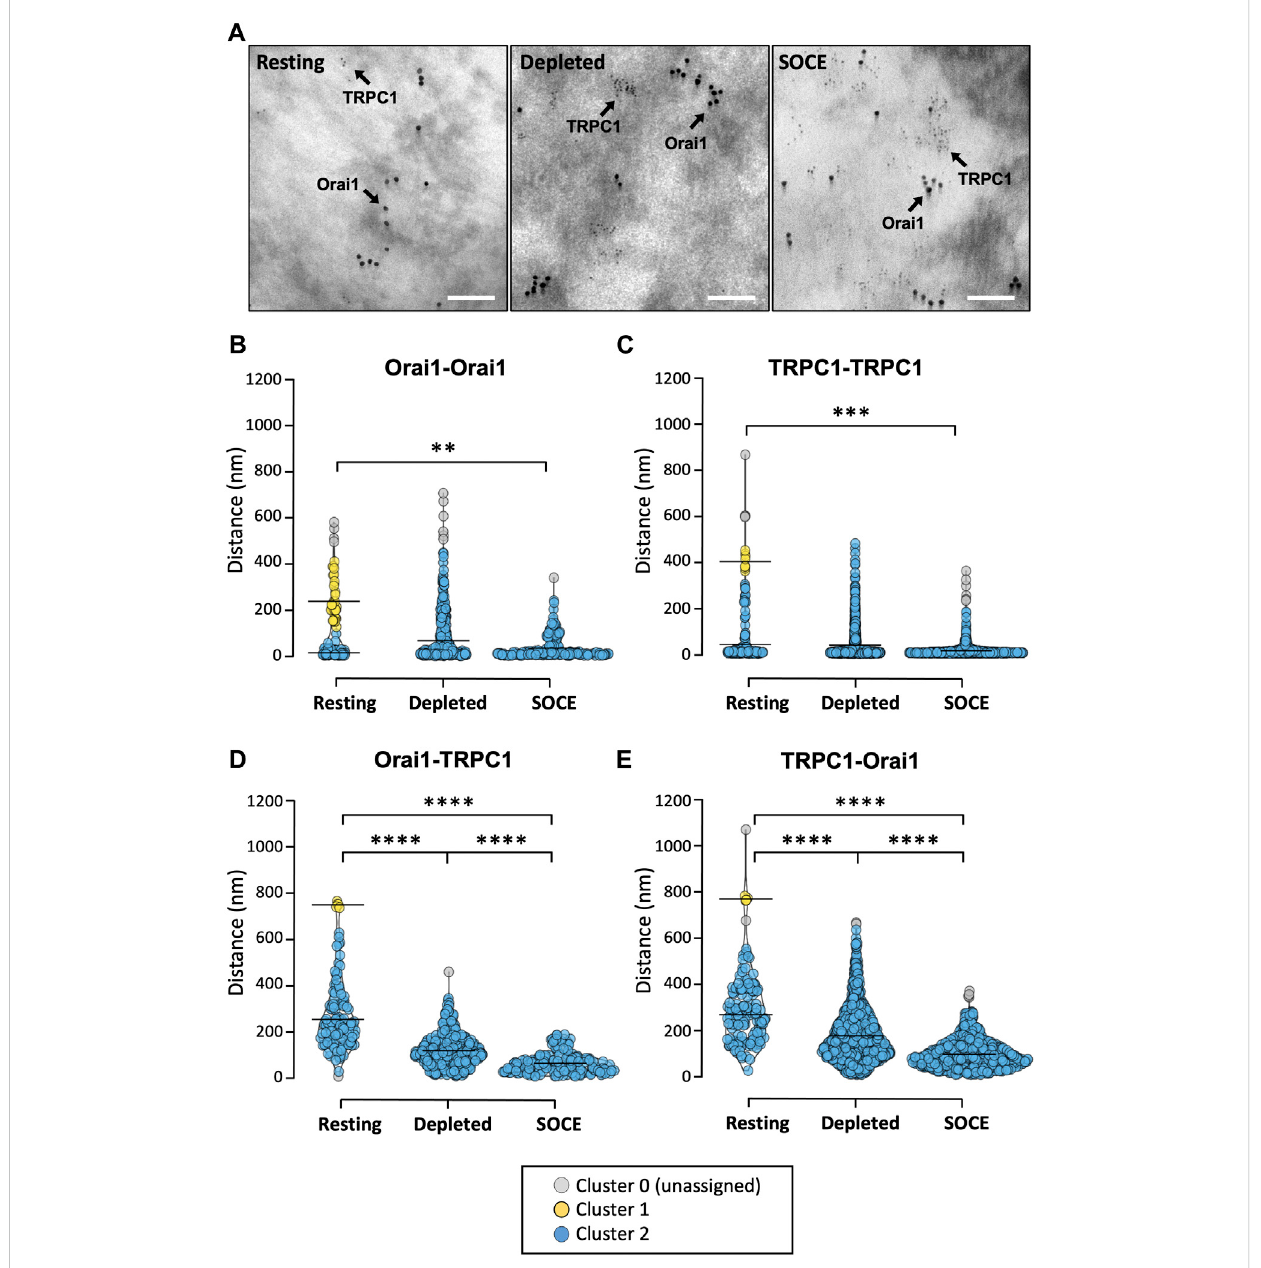
FIGURE 3 TRPC1 and Orai1 channel populations cluster and co-localize under Ca 2+ store depletion and SOCE conditions. (A) Representative transmission electron micrographs of HaCaT cell membrane rip-offs ( N = 3 biological replicates per condition) immunolabelled with 10 nm and 3 nm diameter gold nanoparticles targeted to Orai1 and TRPC1, respectively (scale bar 100 nm). (B) Distances between gold particles were measured to calculate nearest- neighbour distances and the DBSCAN technique used to assess whether these Euclidean distances were clustered and whether identi fi ed cluster con fi gurations altered with treatment. Clustering was quanti fi ed for four different distance combinations [Orai1-Orai1 (B) ; TRPC1-TRPC1 (C) ; Orai1- TRPC1 (D) ; TRPC1-Orai1 (E) ] under three conditions each (at rest, during store depletion, and during SOCE). For all conditions two clusters [cluster 1 (yellow) and cluster 2 (blue)] were detected atrest. Cluster 0 (grey) denotes particles not attributedto any cluster. Onlyone cluster (blue) was detected in all conditions following store depletion and SOCE. The mean distance between particles in each identi fi ed cluster is indicated by the horizontal line. Signi fi cance levels refer to the median distance between all particles within the population for a given condition (Kruskal-Wallis with Dunn ’ s multiple comparisons; ** p = 0.006; *** p = 0.0009; **** p < 0.0001; see text for